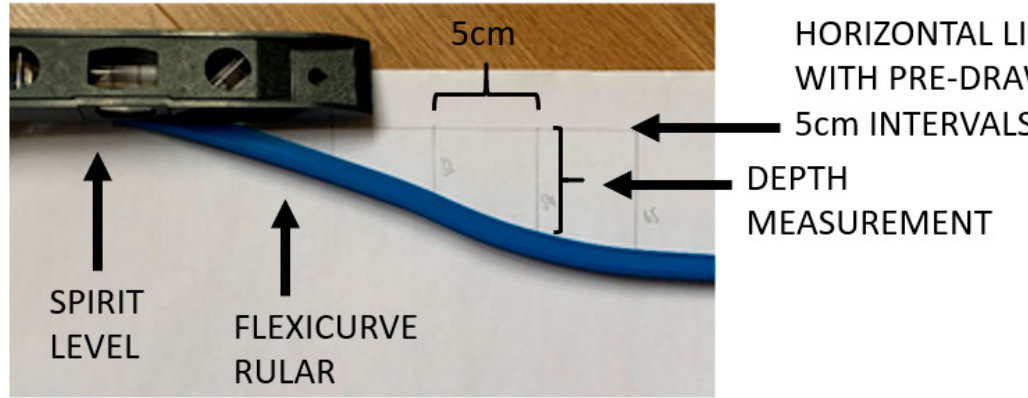
Figure 2. The aFCR (adapted Flexicurve Ruler), with the spirit level parallel to the pre-drawn 30 cm horizontal line. The horizontal line is split into intervals of 5 cm (5 cm, 10 cm, 15 cm, 20 cm, 25 cm, 30 cm). The distance between horizontal line, at these marked intervals, and the trace of the sagittal profile was measured in millimetres.